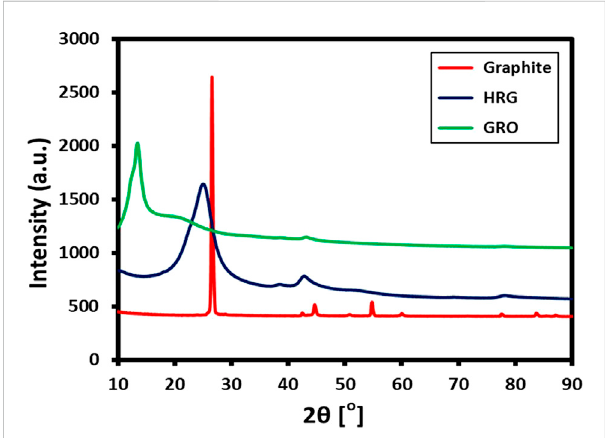
FIGURE 5 HRTEM analysis of highly reduced graphene oxide